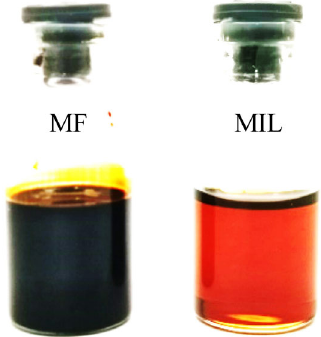
Fig. 3 Digital camera pictures of the MIL and MF.